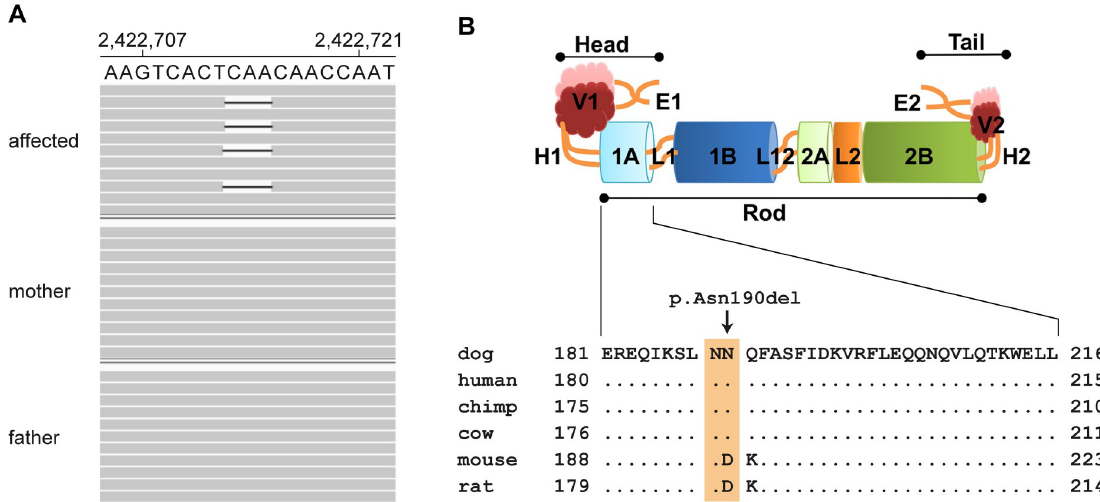
Fig 3. Details of the KRT1 :c.567_569del, p.(Asn190del) variant. (A) Integrative Genomics Viewer (IGV) screenshot showing the short- read alignments of the ichthyosis affected puppy and its non-affected parents at the position of the deletion. A deletion of one copy of the allele is visible in the case but not in the parents. Note that in the IGV screenshot bases 2,422,713–2,422,715 are deleted, whereas the 3’-rule of HGVS nomenclature requires to designate this variant as Chr27:2,422,716_2,422,718del (CanFam3.1). (B) Schematic representation of the protein domain structure of a keratin dimer [20] with the highly conserved amino acid sequence of the coil 1A subdomain shown below. The variant is predicted to delete an asparagine residue from coil 1A, which is located within the rod domain of KRT1.